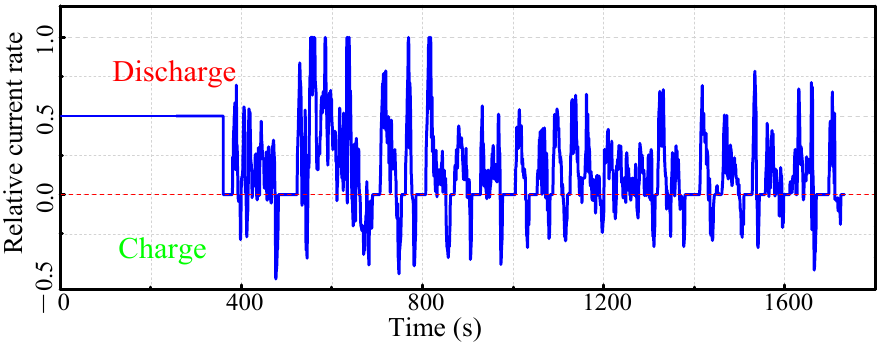
Figure 4. Expanded Federal Urban Driving Schedule (FUDS).